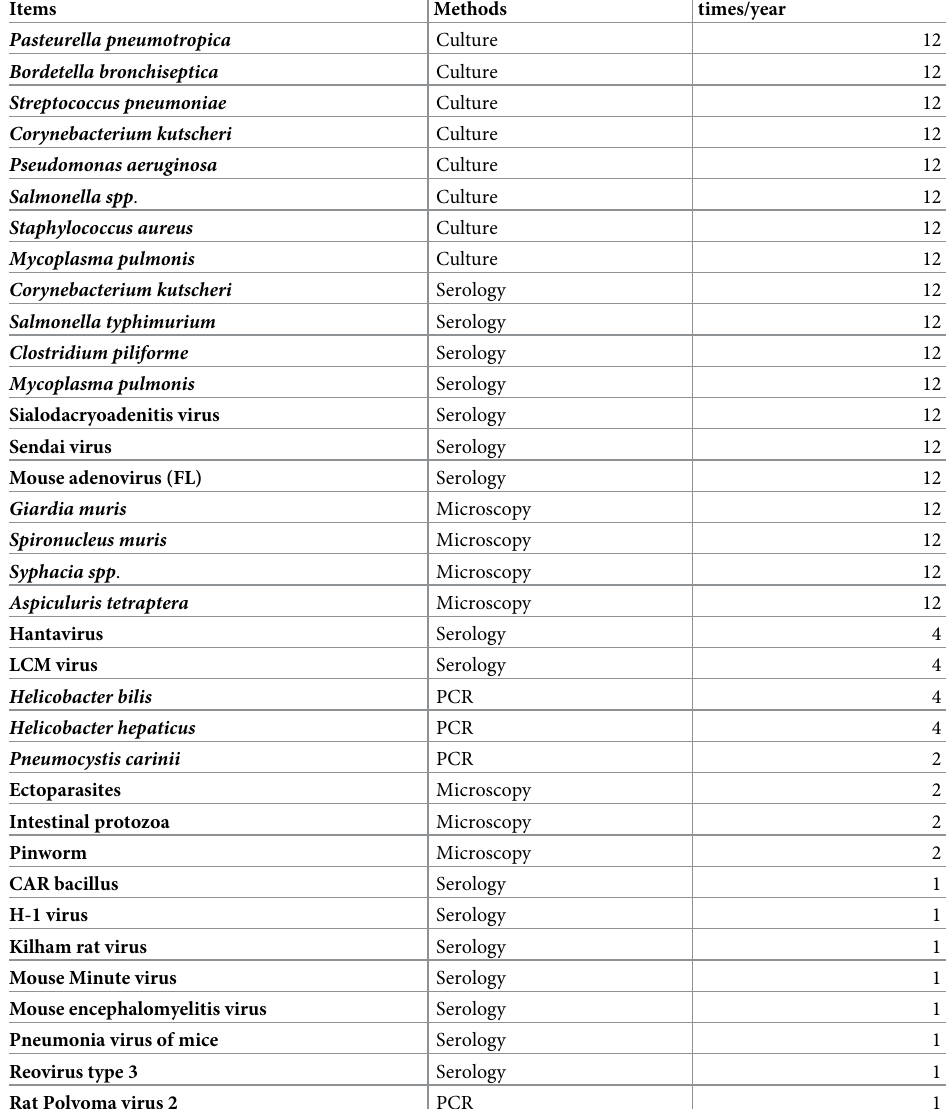
Table 2. Microbiological monitoring